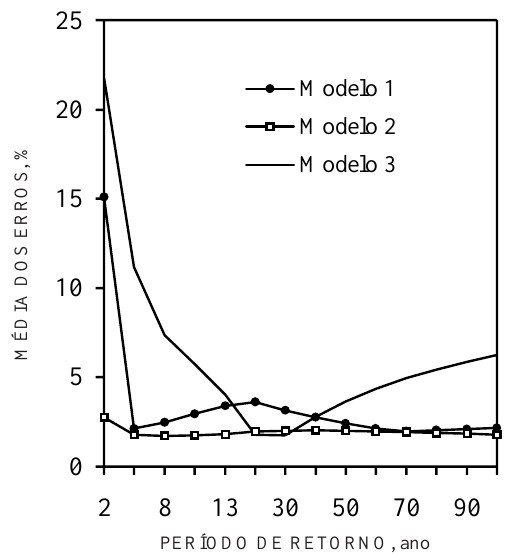
Figura 1. Média dos erros gerados por cada um dos modelos para todos os tempos de retorno considerados e tempo de duração variando de 5 a 240 min.